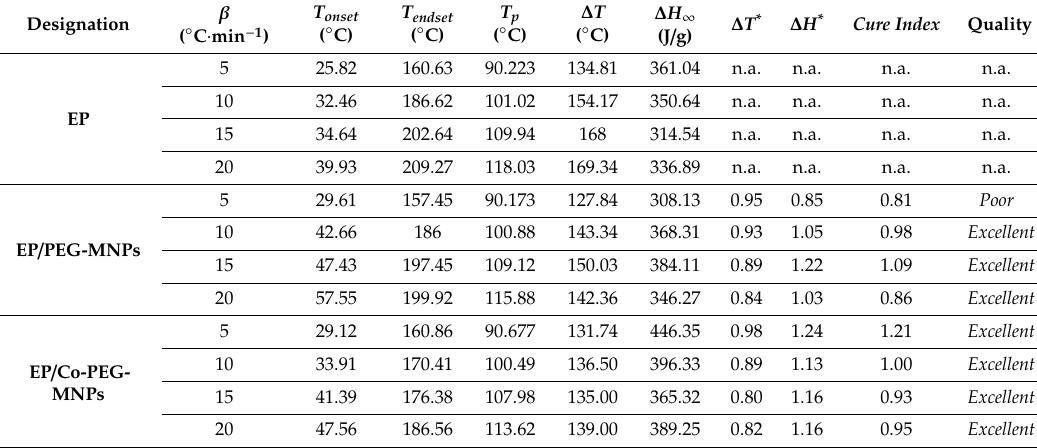
Table 1. Main characteristics of cure reaction of the prepared epoxy nanocomposites in terms of heating rate.